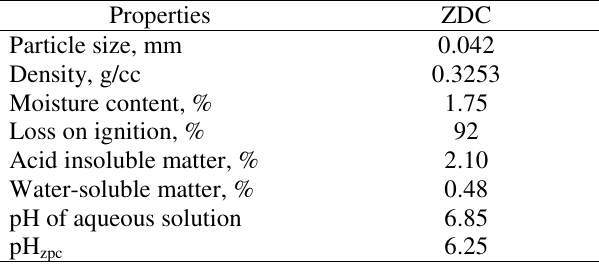
Table 1. Characteristics of the